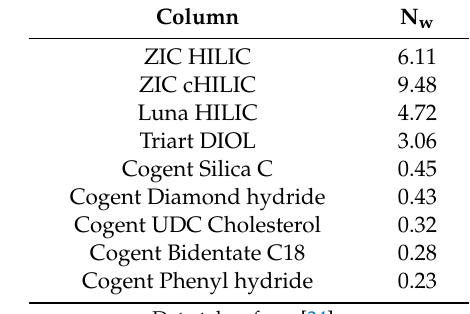
Table 1. Number of water layers on chromatographic stationary phases.